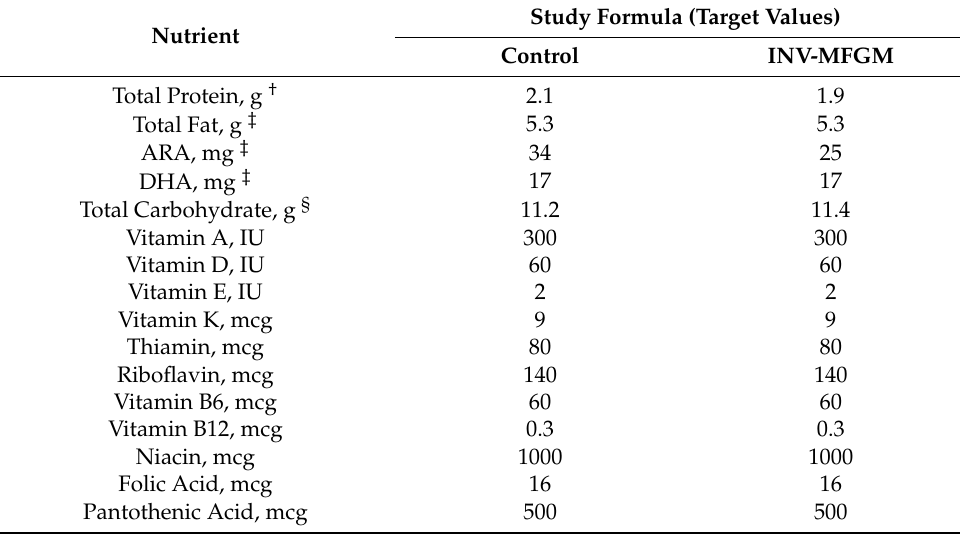
Table 1. Nutrient composition per 100 kcal (20 Calories/fl